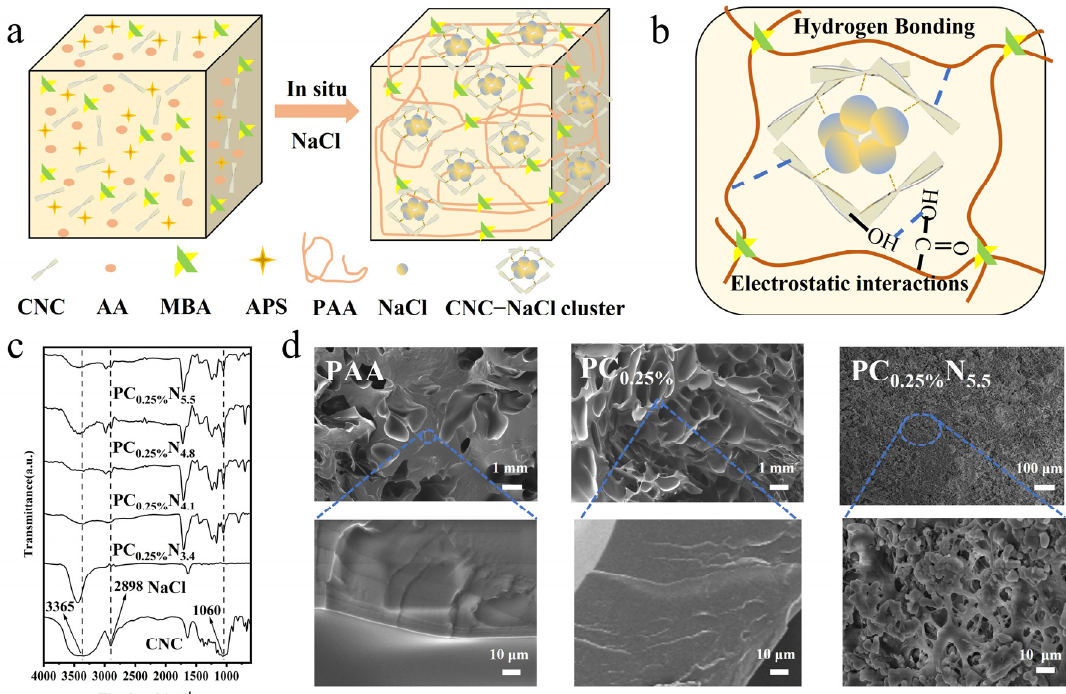
Figure 1. Preparation of salt-percolated nanocellulose composite hydrogel. ( a ) In situ polymeriza- tion of the nanocellulose composite hydrogel. ( b ) Possible noncovalent interactions within the hydrogel matrix. ( c ) FTIR of the CNC and nanocellulose composite hydrogel. ( d ) SEM of the PAA, PC 0.25% , and PC 0.25% N 5.5 hydrogel under different magnifications.